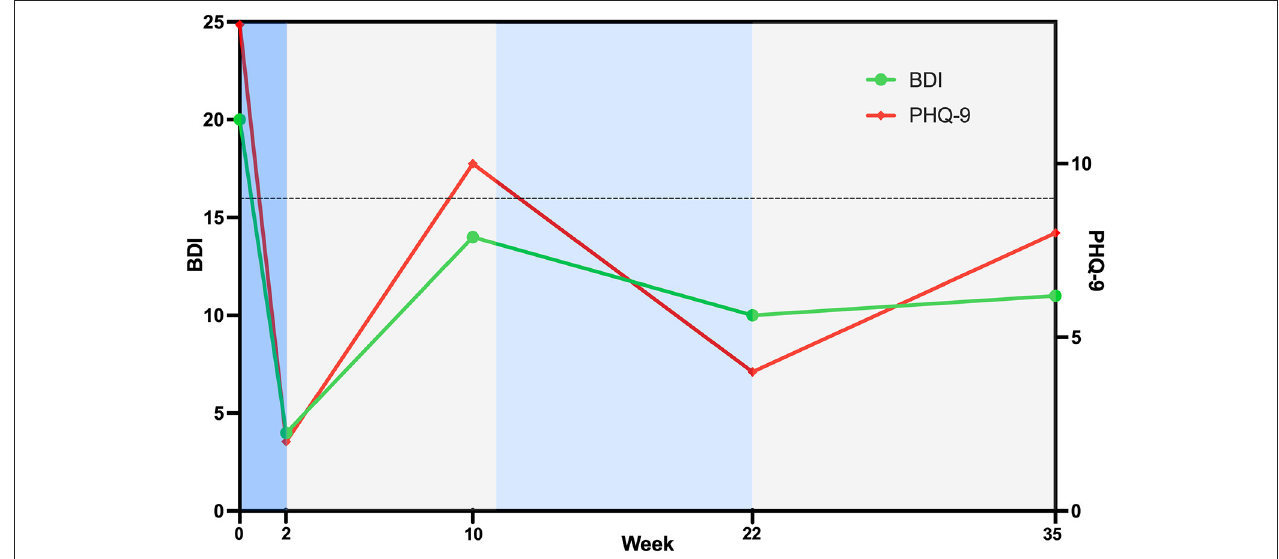
FIGURE 2 | Timeline of treatment and clinical outcomes. High-frequency rTMS treatment to the left dorsolateral prefrontal cortex was delivered during the blue phases, with daily sessions from week 0–2 (darker blue) and weekly sessions from week 11–22 (lighter blue). No rTMS treatment was provided between these times. Threshold for a clinically meaningful improvement from baseline for both the Beck Depression Inventory and Patient Health Questionnaire is shown with a horizontal dotted line. Data points below the dotted line indicate a clinically meaningful improvement in